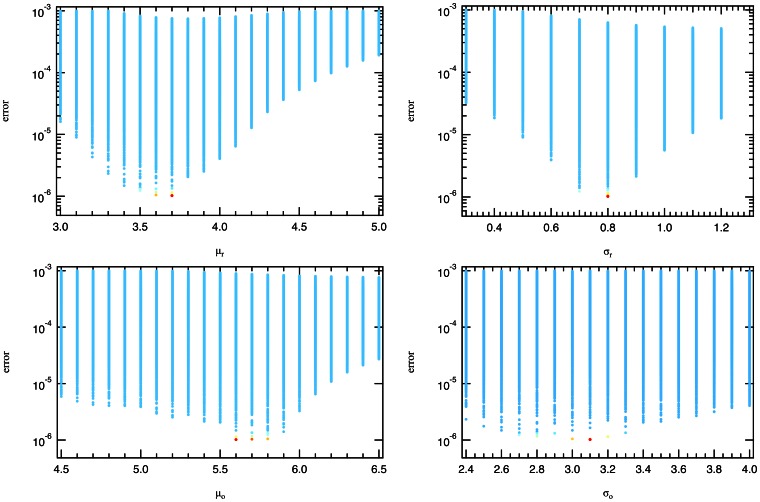
Error of the lognormal fit for Twitter of Figure 3.